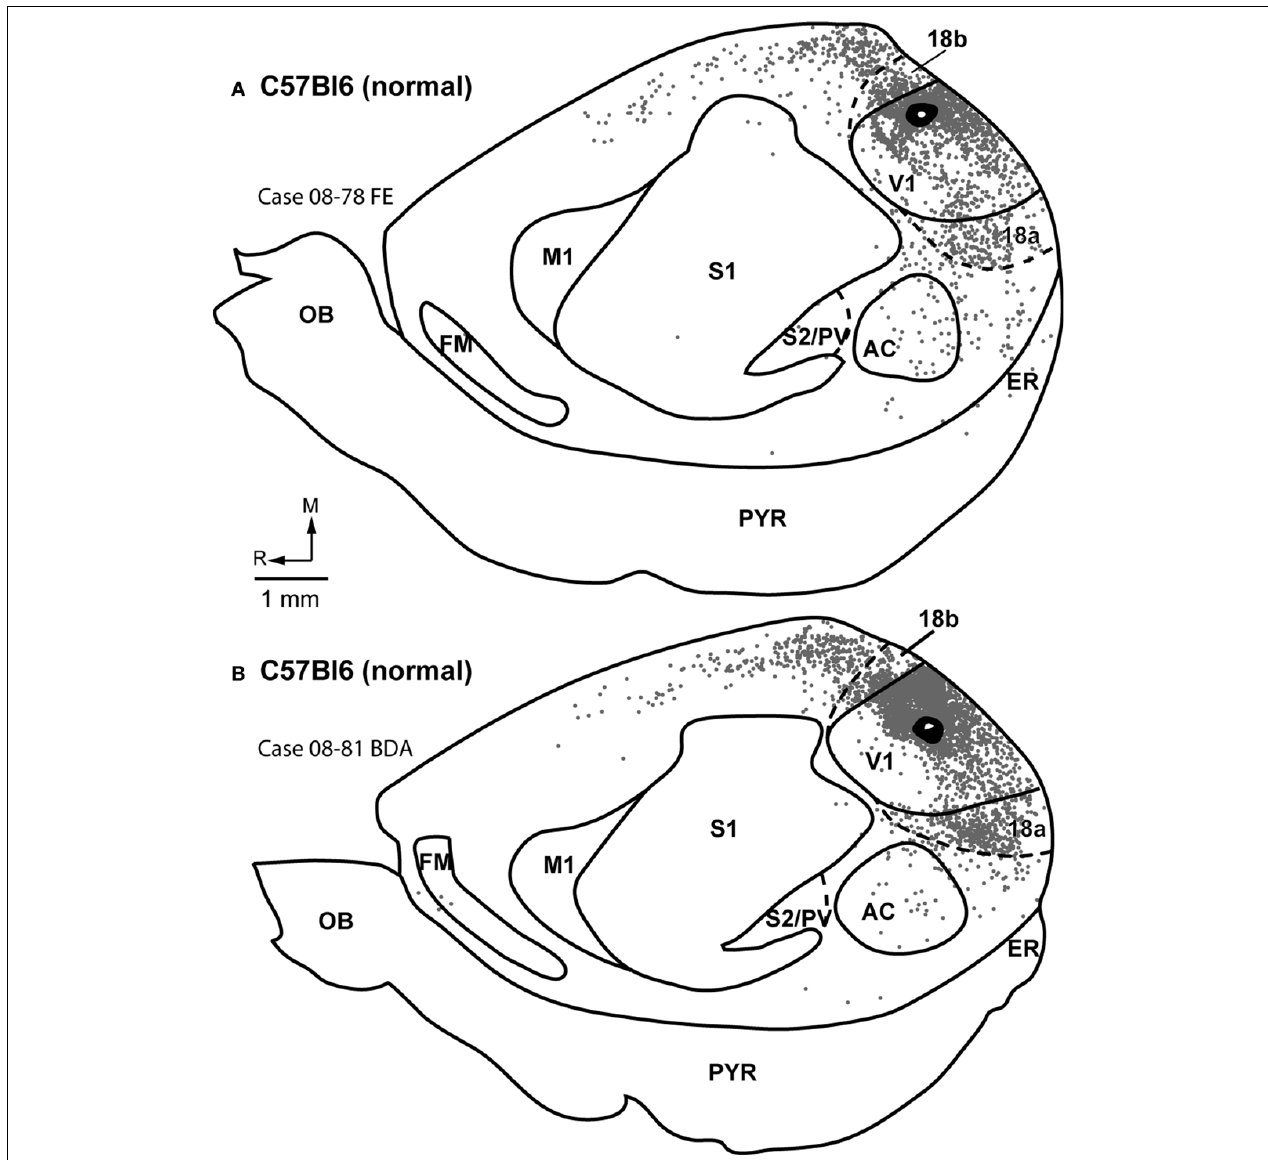
FIGURE 6 | Ipsilateral Cortical Reconstructions of Neuroanatomical Tracer Injections in C57BL6 V1. Reconstructions of cortical connections in C57Bl6 mice (A,B) showing the location of retrogradely labeled cell bodies from neuroanatomical tracer injections in V1 relative to the architectonically defi ned cortical fi elds. The dots mark the locations of labeled cell bodies. The locations of